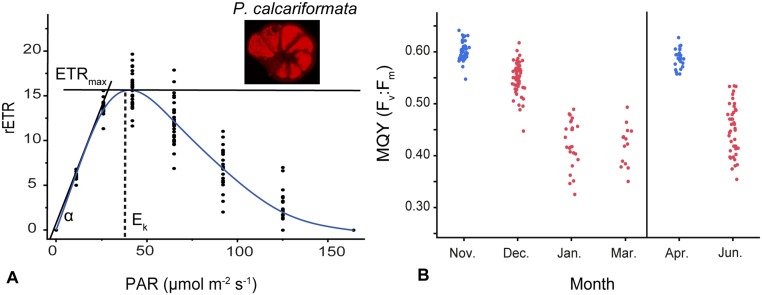
Photochemical activity in endosymbionts of the foraminifer Pararotalia calcariformata.A) Rapid light curve showing relative electron transport rates (rETR) under different levels of photosynthetically active radiation (PAR) on low-light adapted specimens (n = 30). The curve shows a cubic spline with a lambda of 0.05, α represents slope of the curve. ETRmax represents the maximum height of the curve and Ek the minimum saturating irradiance level. Small photograph shows a live specimen under epifluorescence microscopy containing photosynthetically active symbionts. B) Maximum quantum yield (Fv:Fm) measured on two populations collected in 11/2012 and 04/2013 (n = 14–48) and monitored in the laboratory for several month. Blue dots represent measurements made one week after collection. Red dots represent measurements of cultured specimens.